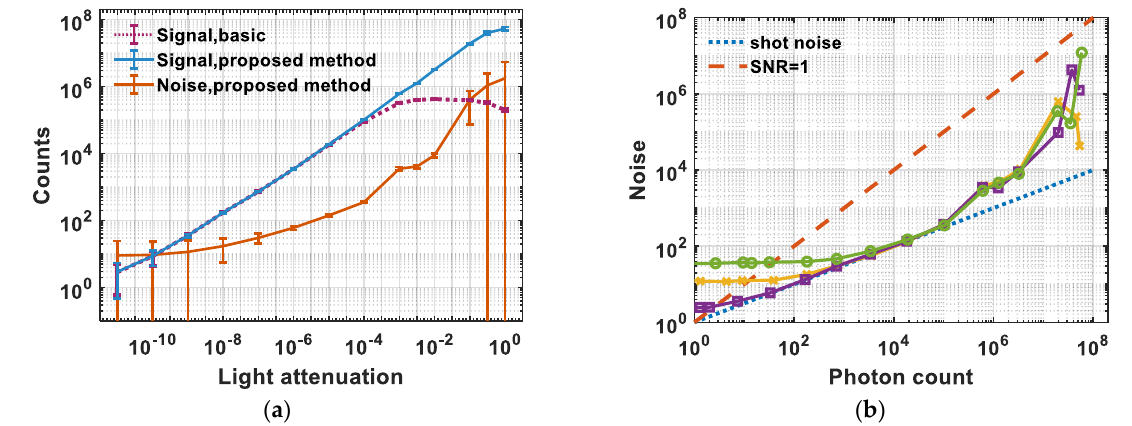
Figure 5. Both plots are at t exp = 30-ms: ( a ) average and non-uniformity (error bars) of estimated optical signal and noise from 49 pixels; ( b ) photon transfer curve for three pixels.